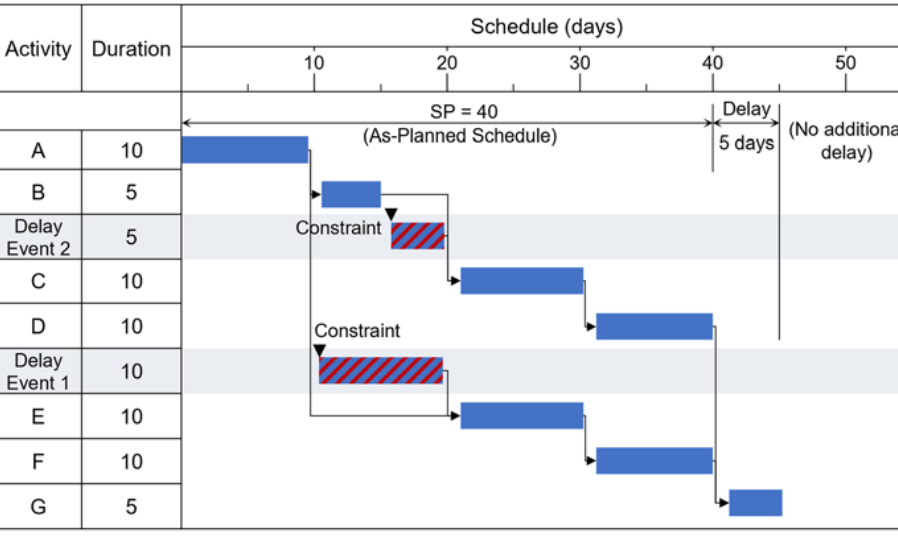
Figure 11. Impacted as ‐ planned using constraint. The as ‐ planned schedule in step ‐ by ‐ step insertion contains most delay events and changes that occurred before any single delay event to be analyzed. Even if the as ‐ planned schedule was updated with changes or delays, there is still a potential that the as ‐ planned schedule does not incorporate all the network’s earlier delays or changes. That is, the as ‐ planned schedule may differ from the most recent as ‐ built schedule. As shown in Figure 6, as pointed out by Kim and Kwon [21], inserting delay events with constraints could lead to an overestimate of the impact of a delay event. When the delaying events are added to the network by using constraints based on its actual start and finish date, the delay of the project completion could be overestimated. This type of overestimation, on the other hand, can only occur when the completion delay is greater than the duration of the delay